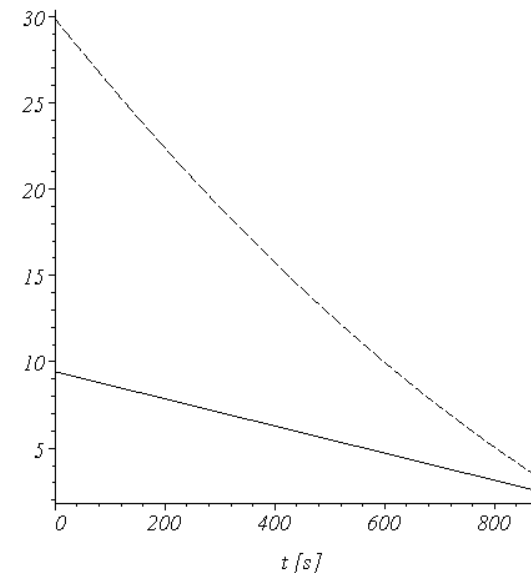
Fig 5. Change in the number of attacking (stroke line) and Fig 6. Change in the number of attacking (stroke line) and defending (line) soldiers during the attack. r – distance between defending (line) soldiers during the attack. t - time since the start the adversaries of the